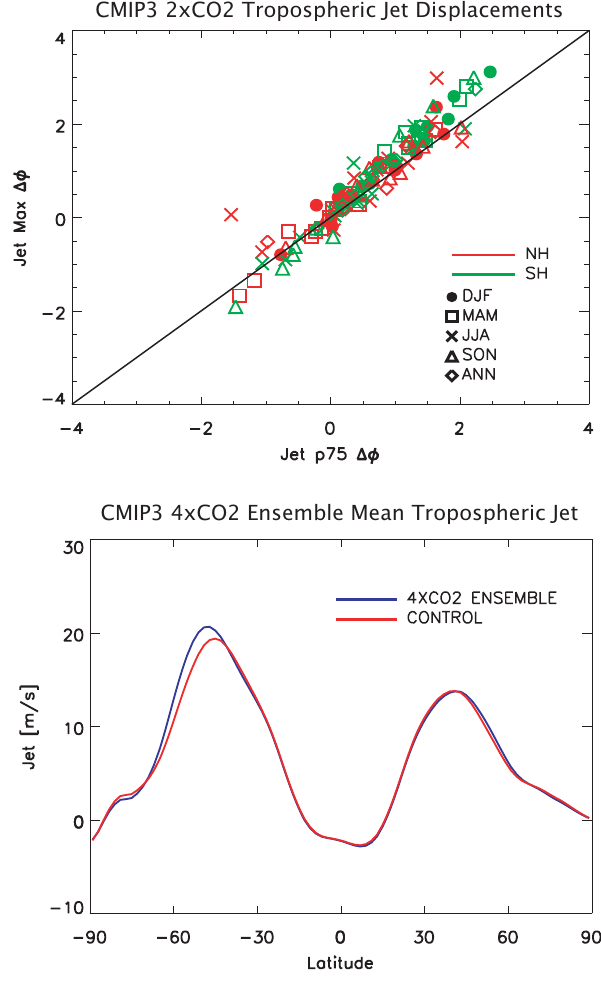
Fig. 1. (Top panel) Tropospheric poleward jet displacement [de- grees latitude] based on 12 CMIP3 2 × CO2 equilibrium experi- ments using the maximum zonal wind method (Jet Max) and the percentile method with the 75th percentile (Jet p75). (Bottom panel) The ensemble annual zonal mean tropospheric jet (850–300hPa U ) response based on 10 1% to 4 × CO2 transient CMIP3 experiments, along with the corresponding